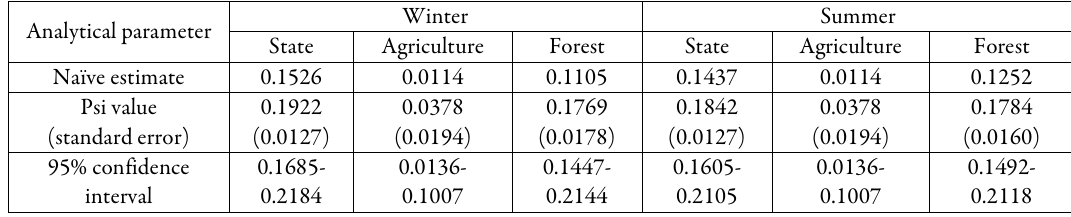
Table 2. Results of occupancy analysis of vultures in Central